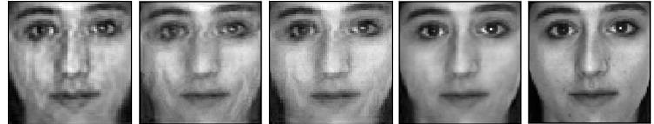
Figure 4. Enlarged restored images. From left to right, it is the restored images of DnCNN, ResNet, ResNet with dilated convolution and FbResNet, and the last is the clean image.